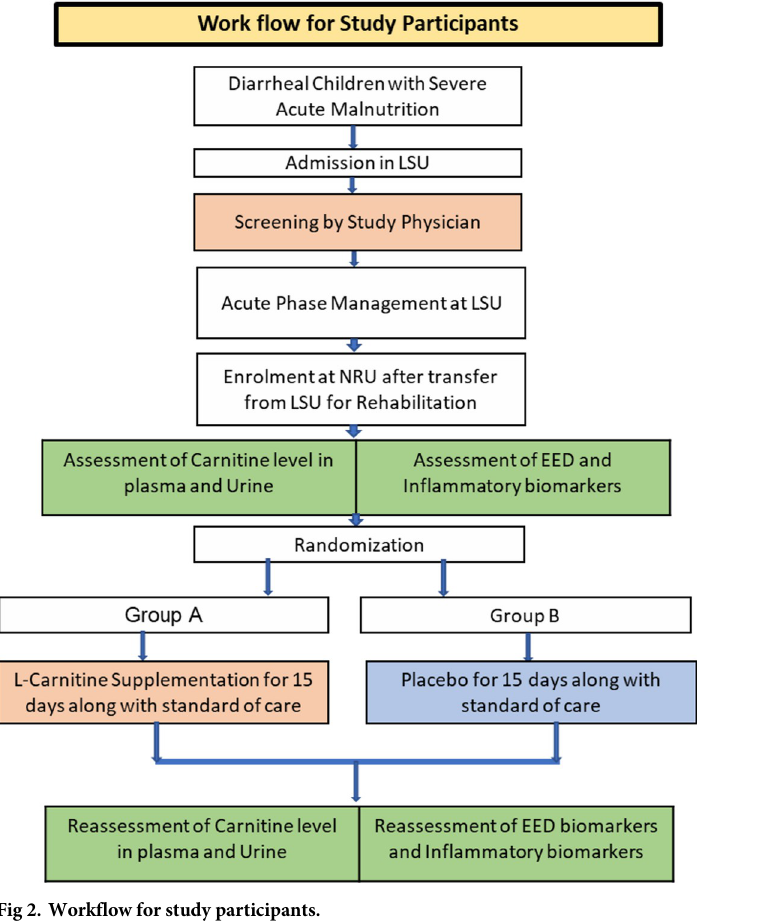
Fig 2. Workflow for study